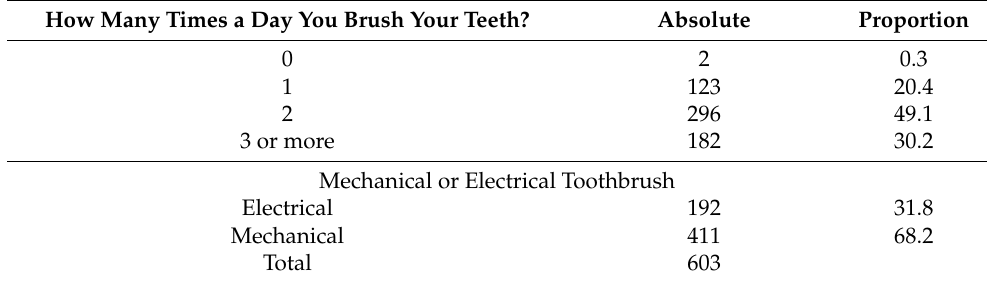
Table 3. Oral hygiene home